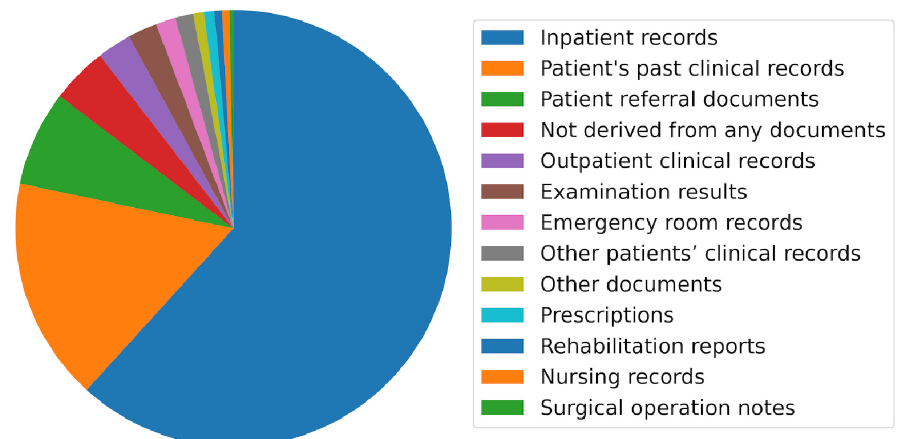
Fig 6. Breakdown of the information source in discharge